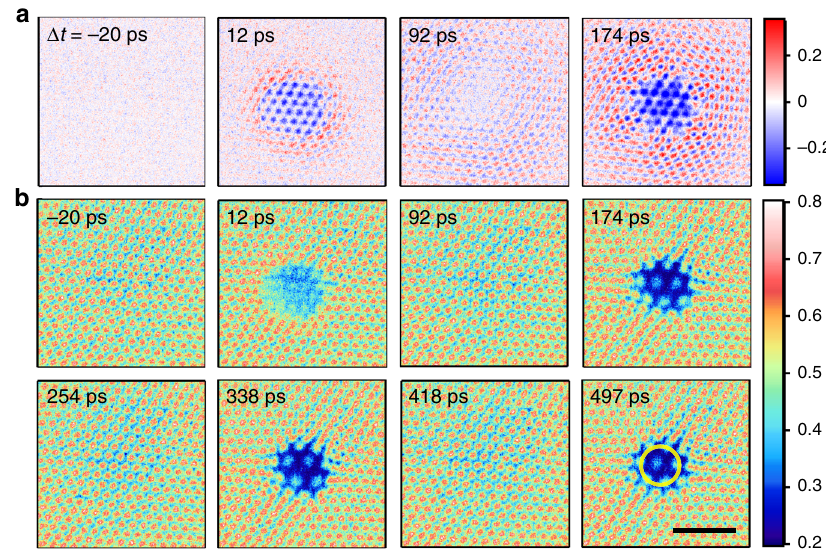
Fig. 2 Transient electron-gas lensing images. Series of 3000 mesh copper grid images ( b ) and difference images ( a ) extracted from a ps-resolved UEM movie (528 nm, 200 fs, 30 mJ/cm 2 laser excitation) with an objective lens current of 0.7 A. The time delays correspond to the fi rst few local maxima and minima in the ROI difference intensity trace in Fig. 3. The difference images were generated by subtracting an averaged image before time zero ( Δ t = 0). A typical region-of-interest (ROI) circle that is used to make plots of the intensity changes due to lensing is indicated in the last frame. The scale bar at the bottom right is 50 μ m and applies to all images. The intermediate lens current was set to 0.65 A.